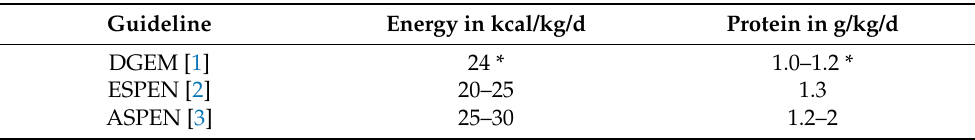
Table A1. Weight based calculation of macronutrient requirements, *, recommendation for acute phase, use actual body weight for